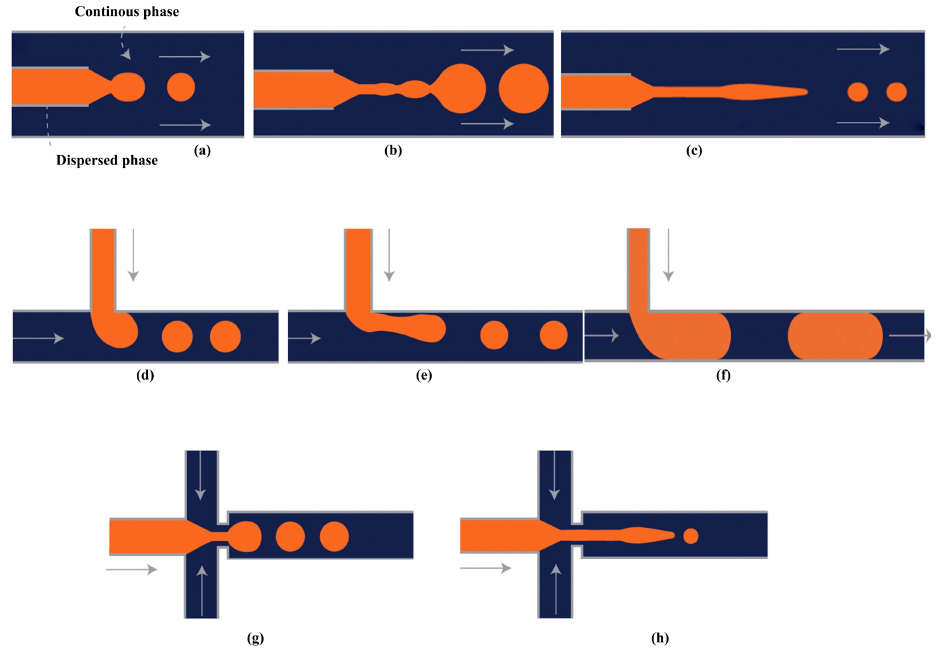
Figure 2. A droplet breakup in each of the three main microfluidic geometries used for droplet formation; ( a – c ) show dripping, widening jetting and narrowing jetting respectively in co-flow drop makers; ( d – f ) show dripping, jetting and squeezing in T-junction; ( g , h ) show dripping and jetting in flow-focusing drop maker. The orange and dark blue colors represent the dispersed phase and continuous phase respectively.